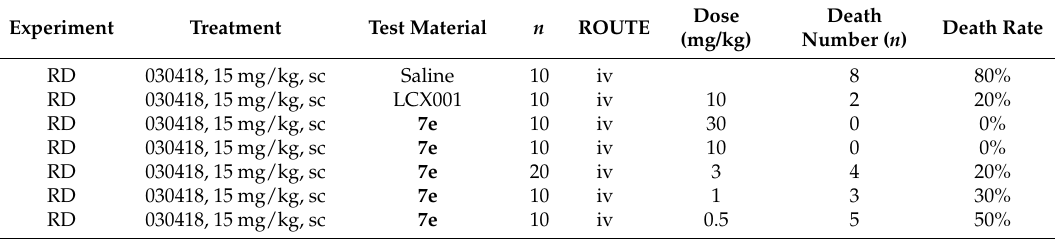
Table 4. Mortality of opiate poisoned mice after administration of LCX001 and prodrug 7e .